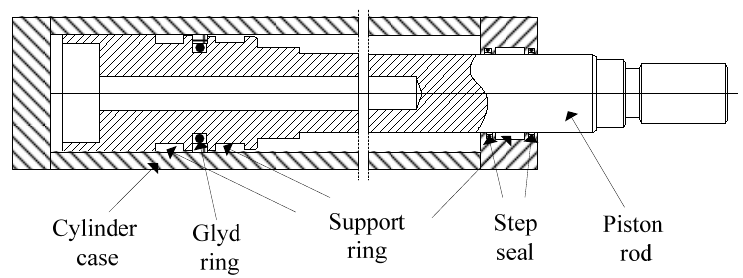
Figure 2. Structure diagram of the hydraulic cylinder.